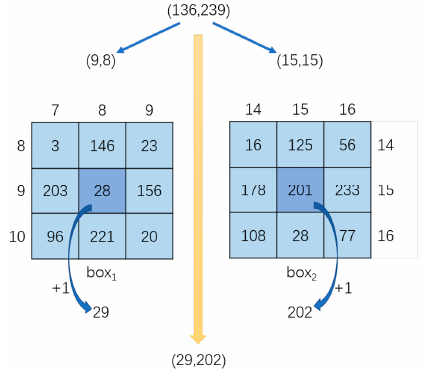
Figure 3. An axis transform